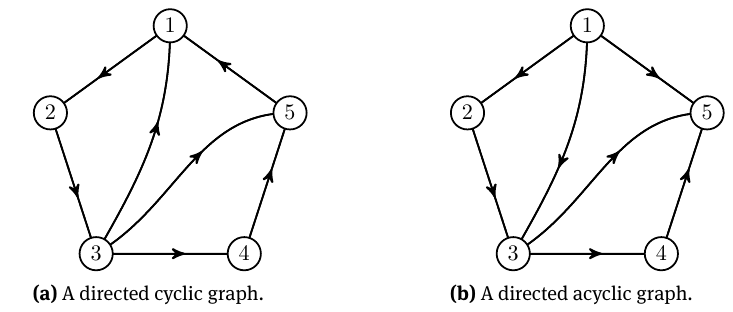
Figure 1: The difference between a directed cyclic graph and a directed acyclic